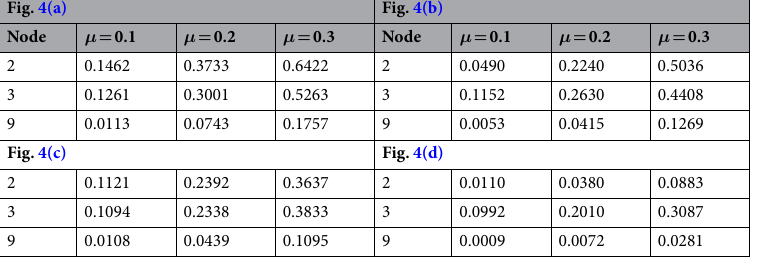
Table 4. The ratio of infected cases among 10000 simulations of nodes 2, 3, and 9 with the original infected source being node 1 before and after edge e (1, 2) being removed in the toy network shown in Fig. 5 under different infected probability μ